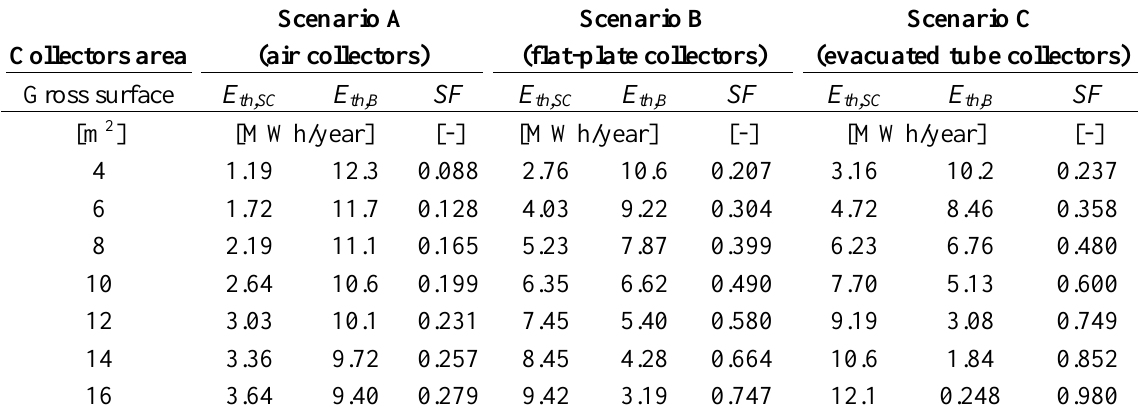
Table 2. Thermal energy supplied by solar collectors and by natural gas boiler.